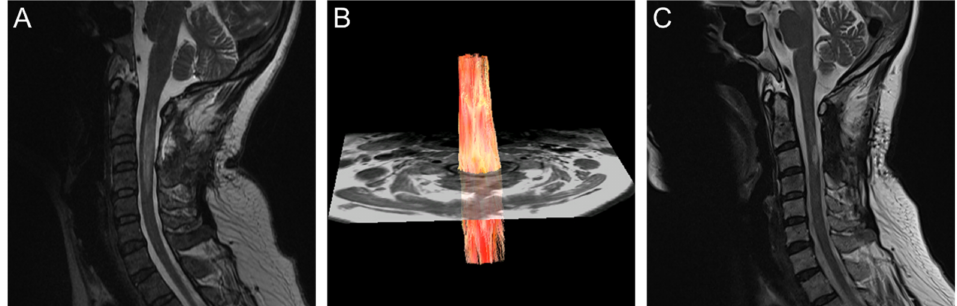
lesion in C2–C4 spinal cord; ( B ) di ff usion-tensor tractography (DTT) showed intact streamline of white-matter tracts without displacement or interruption; ( C ) T2WI after 2 months of medical treatment showed residual faint hyperintensity in C2 spinal cord, and focal myelomalacia corresponding to prior excision biopsy in C3 spinal